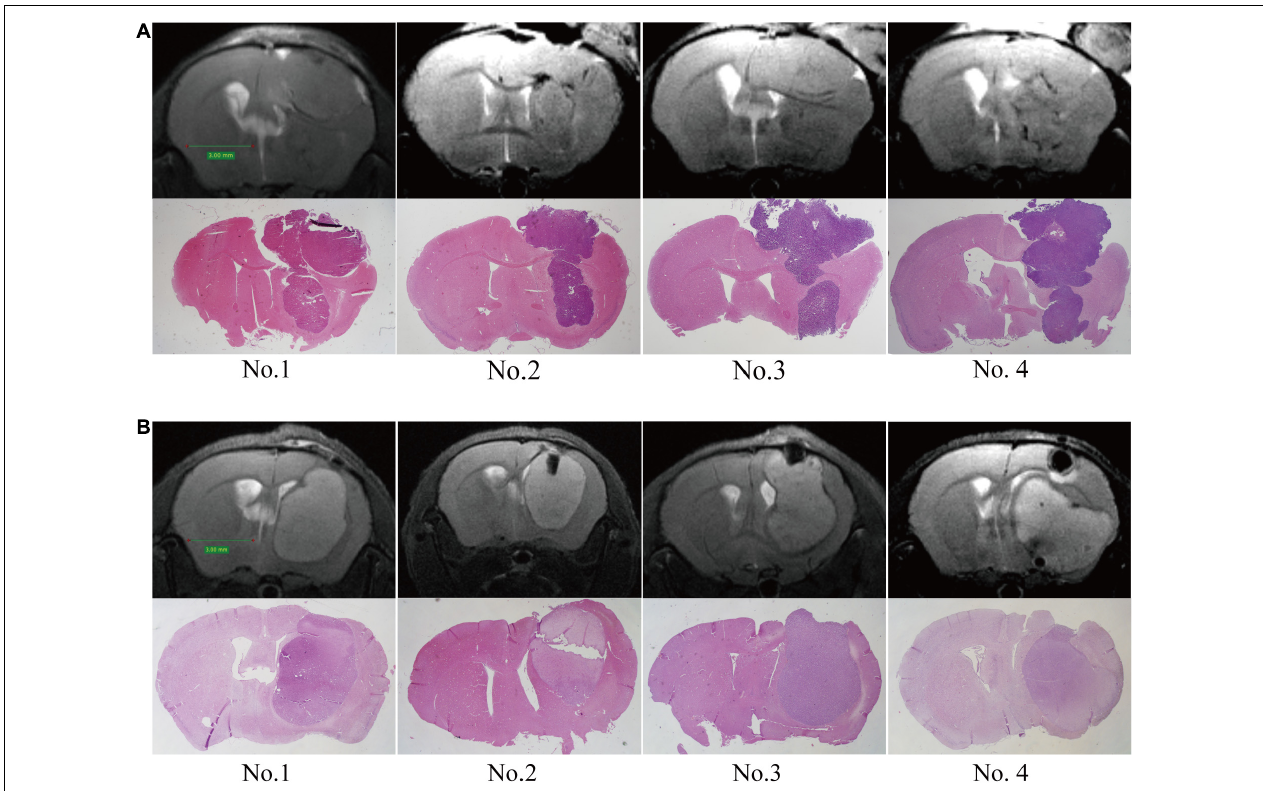
FIGURE 3 | Establishment of orthotopic GBM tumor models. MRI scans were performed at 2 weeks post-implantation, and then upon sacrifice, the brain tissue was further examined by HE staining. (A) C57/BL6 mice were inoculated intracranially with GL261 cells. (B) Nude mice were inoculated intracranially with U87 cells.